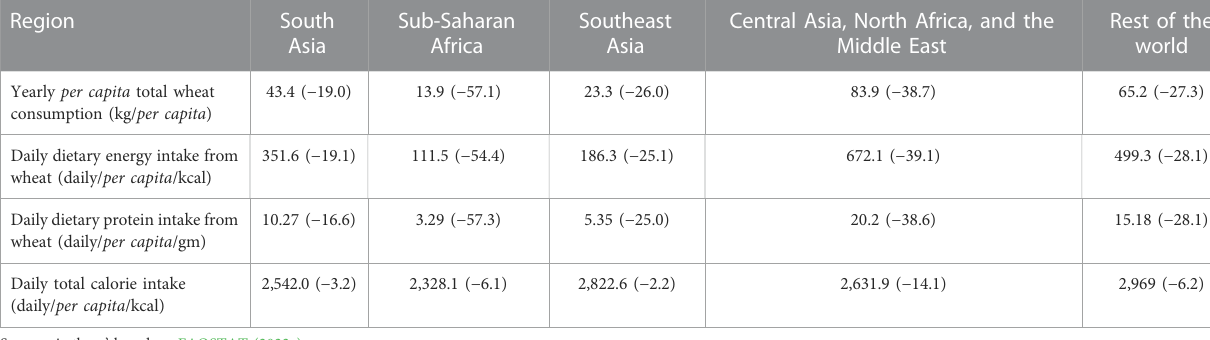
TABLE 7 Impacts of the complete ban (100% reduction of wheat export) of wheat exports from Russia and Ukraine on wheat consumption and nutrient intake in the sampled region. Region